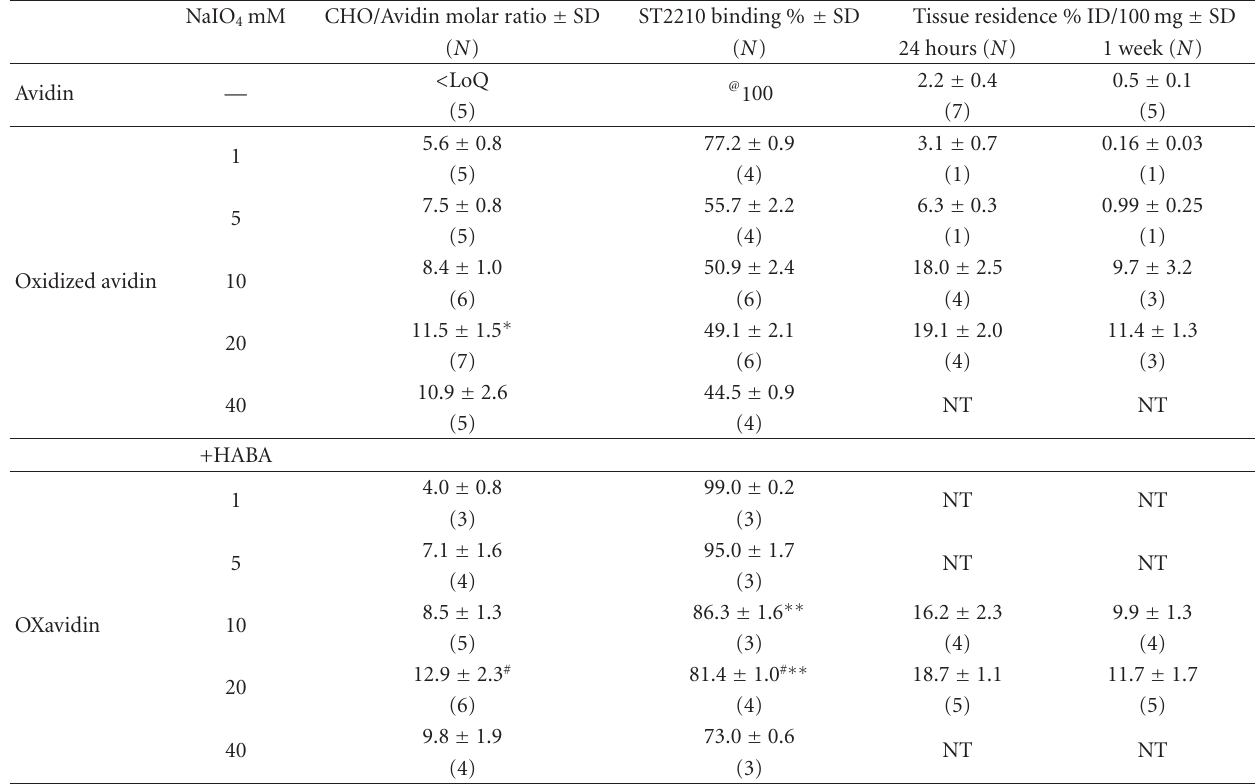
Table 1: Setting up production method of